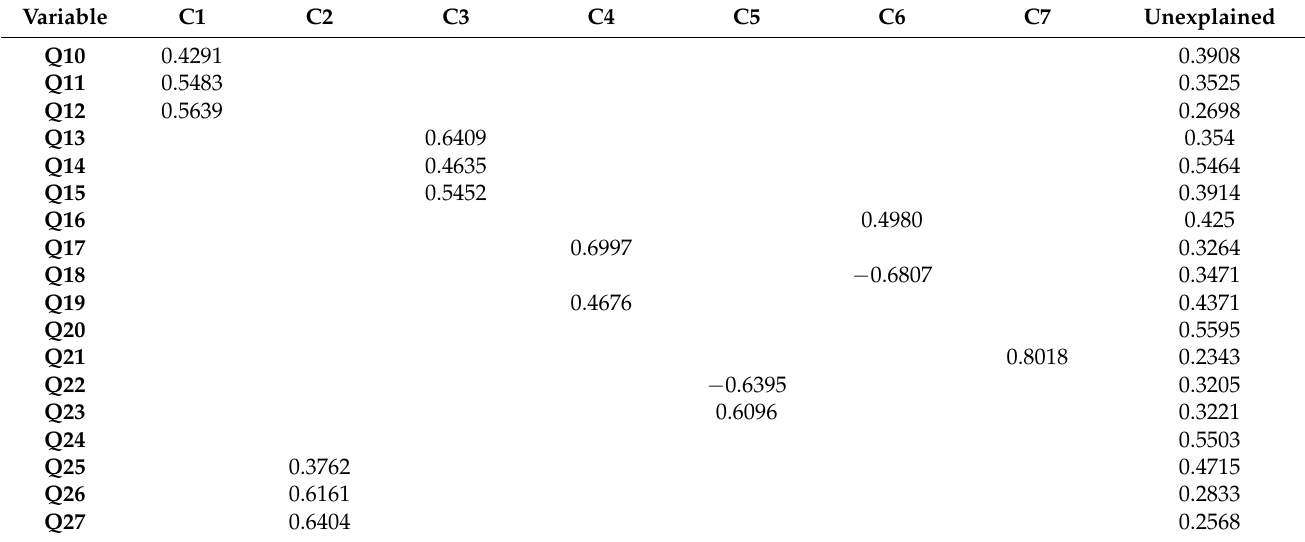
Table A1. Principal components